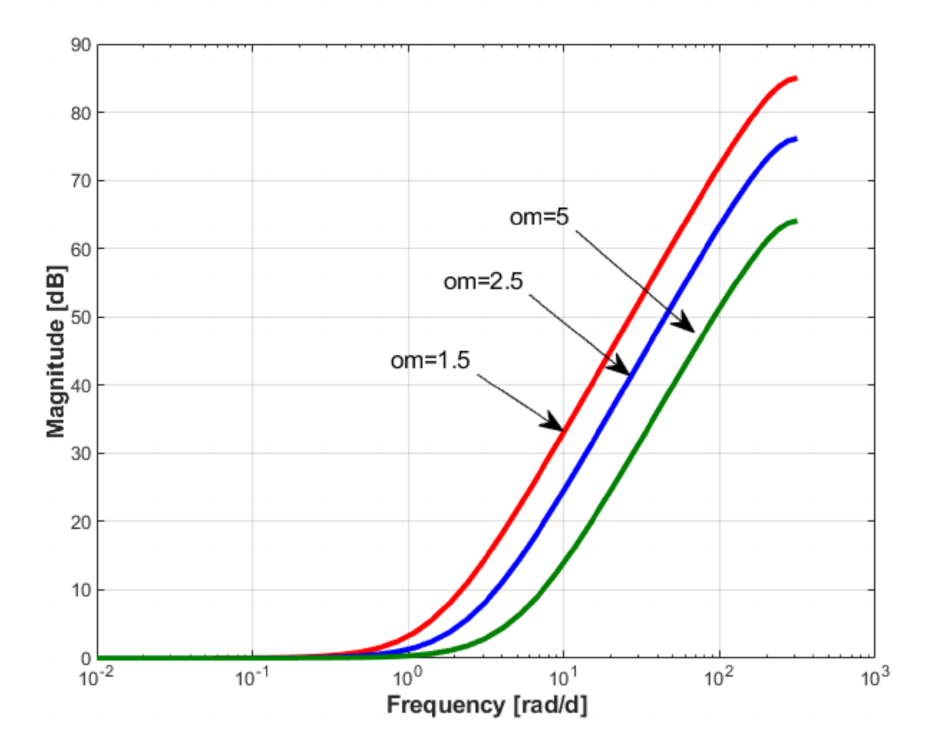
Figure 5. Bode plot of reference models with (cid:101) ω = 1.5,2.5,5.0.